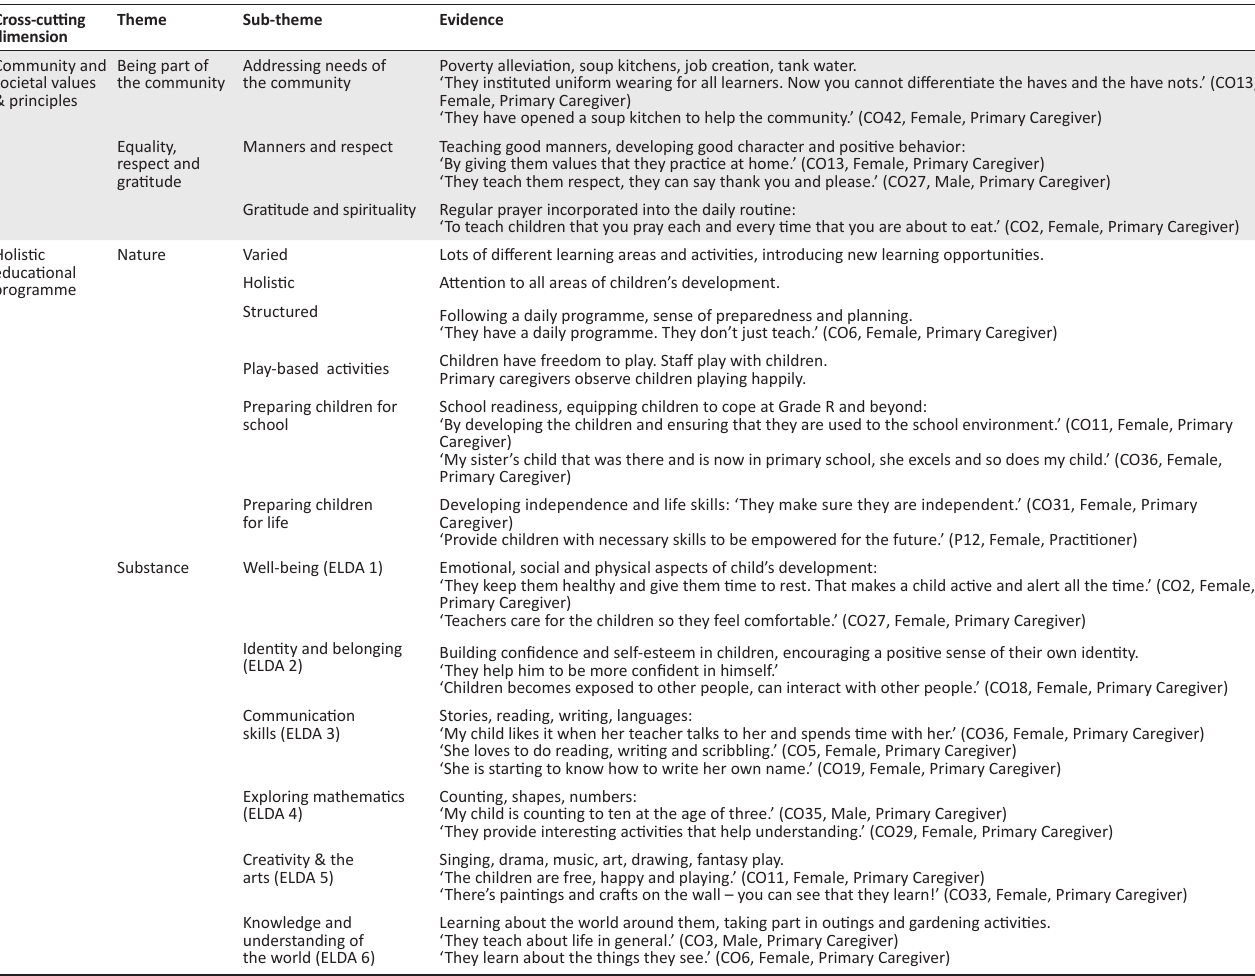
TABLE 2 (Continues...): Data analysis What is quality early childhood development? (Data from primary caregivers and practitioners) Cross-cutting